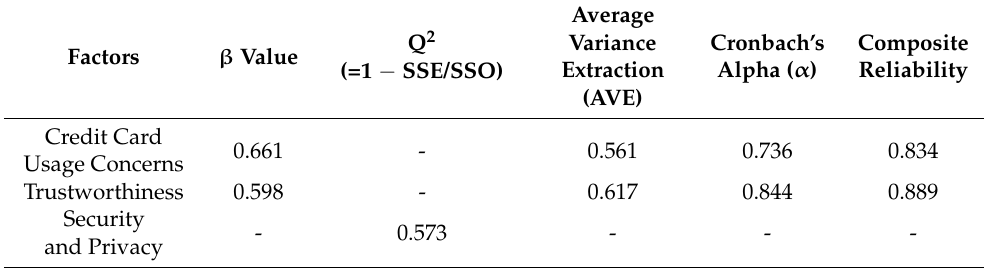
Table 2. Predictive relevance of model factors for Amazon